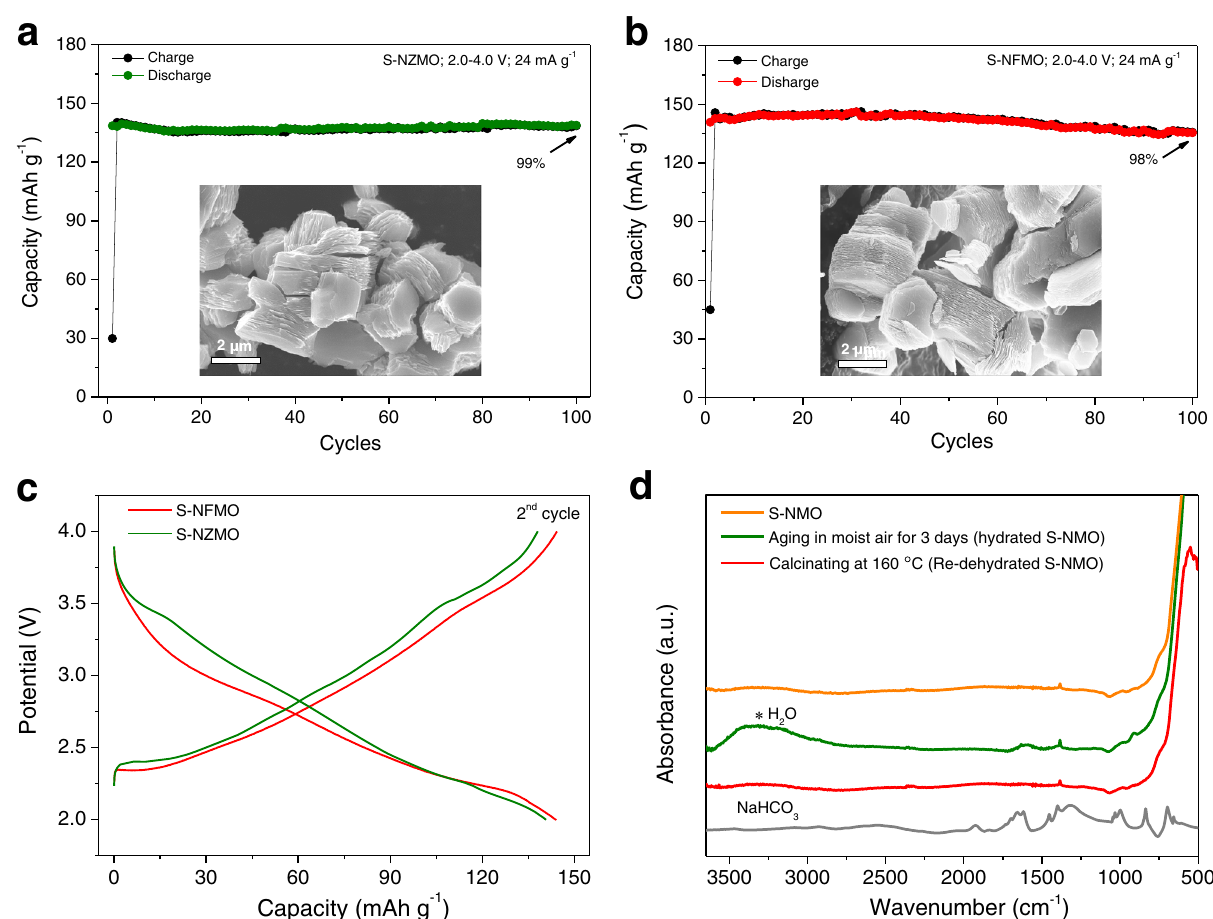
Fig. 7 Merits of the water-mediated method. The morphologies and cycling stability of a S-NZMO and b S-NFMO. c Charge – discharge curves of S-NFMO and S-NZMO within the voltage range of 2.0 – 4.0 V. d FTIR spectra of S-NMO, hydrated S-NMO, and re-dehydrated mixed homogeneously by ball milling with acetone at 350rpmmin − 1 for 12h. The mixture was dried at 120°C for 12h, pressed into pellets, and then sintered at 900°C for 15h in air. The pellets were removed to Ar- fi lled glove box at 150°C, ground into powder, and stored in the Ar- fi lled glove box. Preparation of Shale-like layered sodium oxides . To prepared Shale-like layered sodium oxides, the above synthesized powder was aged on the atmosphere of relative humidity of 93% with the presence of CO 2 (RH 93% + CO 2 ) at 40°C for 6 days 34 . One gram of exposed sample was stirred in 30mL distilled water for 10 min at room temperature, centrifuged and washed with ethanol, dried at 120°C for 6h, and dehydrated at 160°C for 12 h. The fi nal samples were stored at Ar- fi lled glove box.